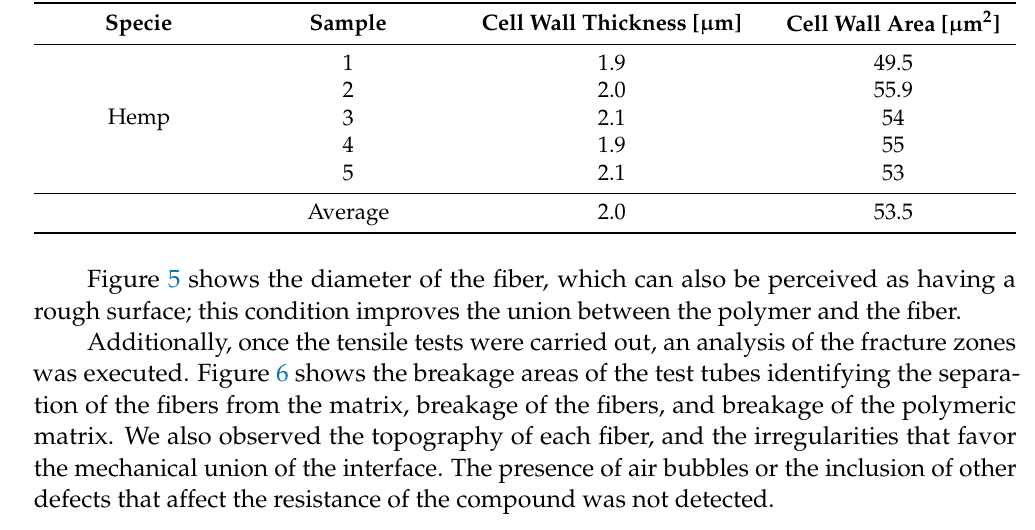
Figure 4. Optical microscopy in a sample of hemp: ( a ) cross section in the stem, 40×; ( b ) cells that make up the fiber, 400 × .